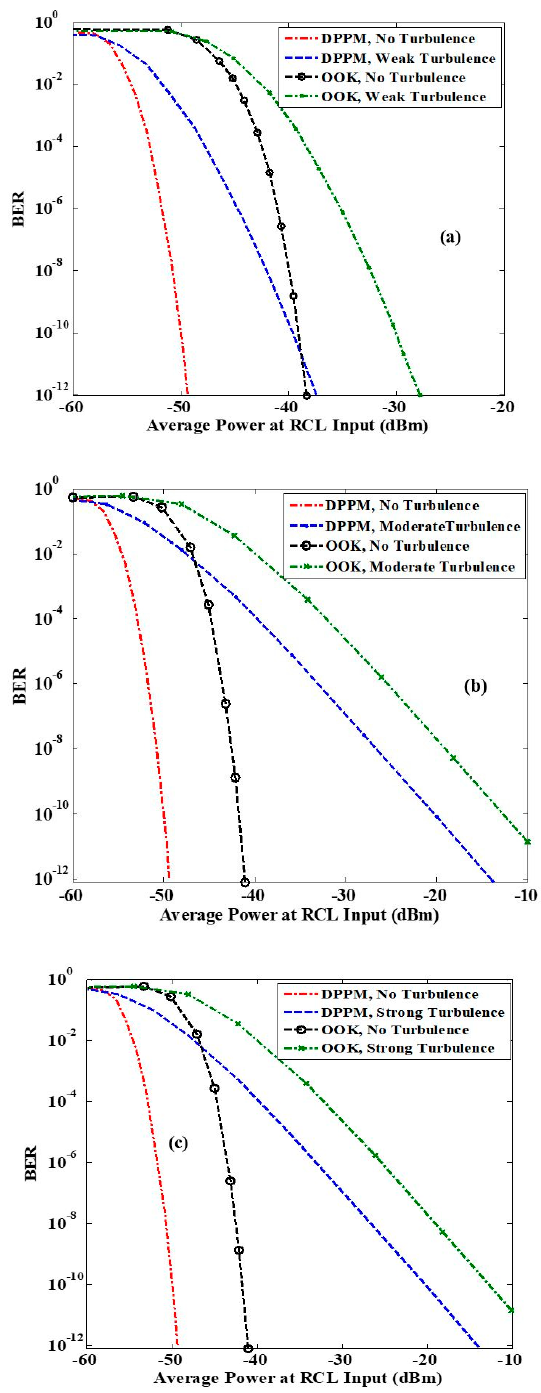
Figure 9. BER vs. AOP at RCL input (dBm) for M-ary DPPM and OOK using D RX = 25 mm, G = 30 dB, M = 5, and 𝑙 (cid:3033)(cid:3046)(cid:3042) = 4000 m for NT with ( a) WT, ( b) MT, and ( c) ST Table 2. The proposed M-ary DPPM-M-PAPM based modulation schemes DWDM-FSO optical fiber communication network system [2,8,9,17,42,50].